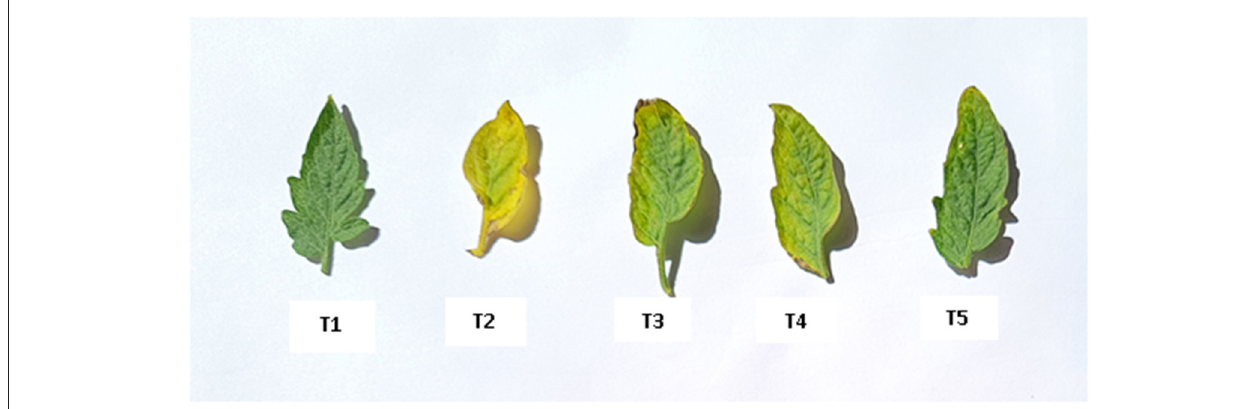
FIGURE 6 | Yellowing of leaves as observed after various treatments.